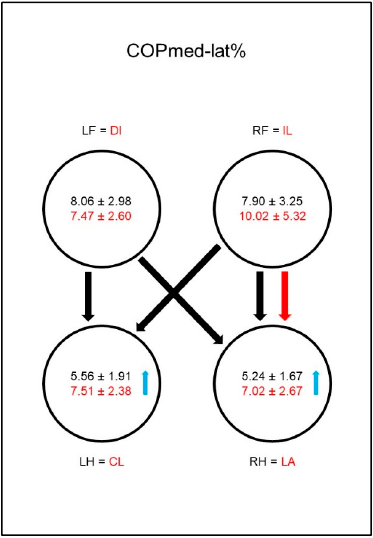
Figure 6. Medio–lateral displacement of the center of pressure as a percentage of maximum width of paw contact area (COPmed-lat%) in study group 1 and control group. For detailed explanation and abbreviations refer to Figure 2.